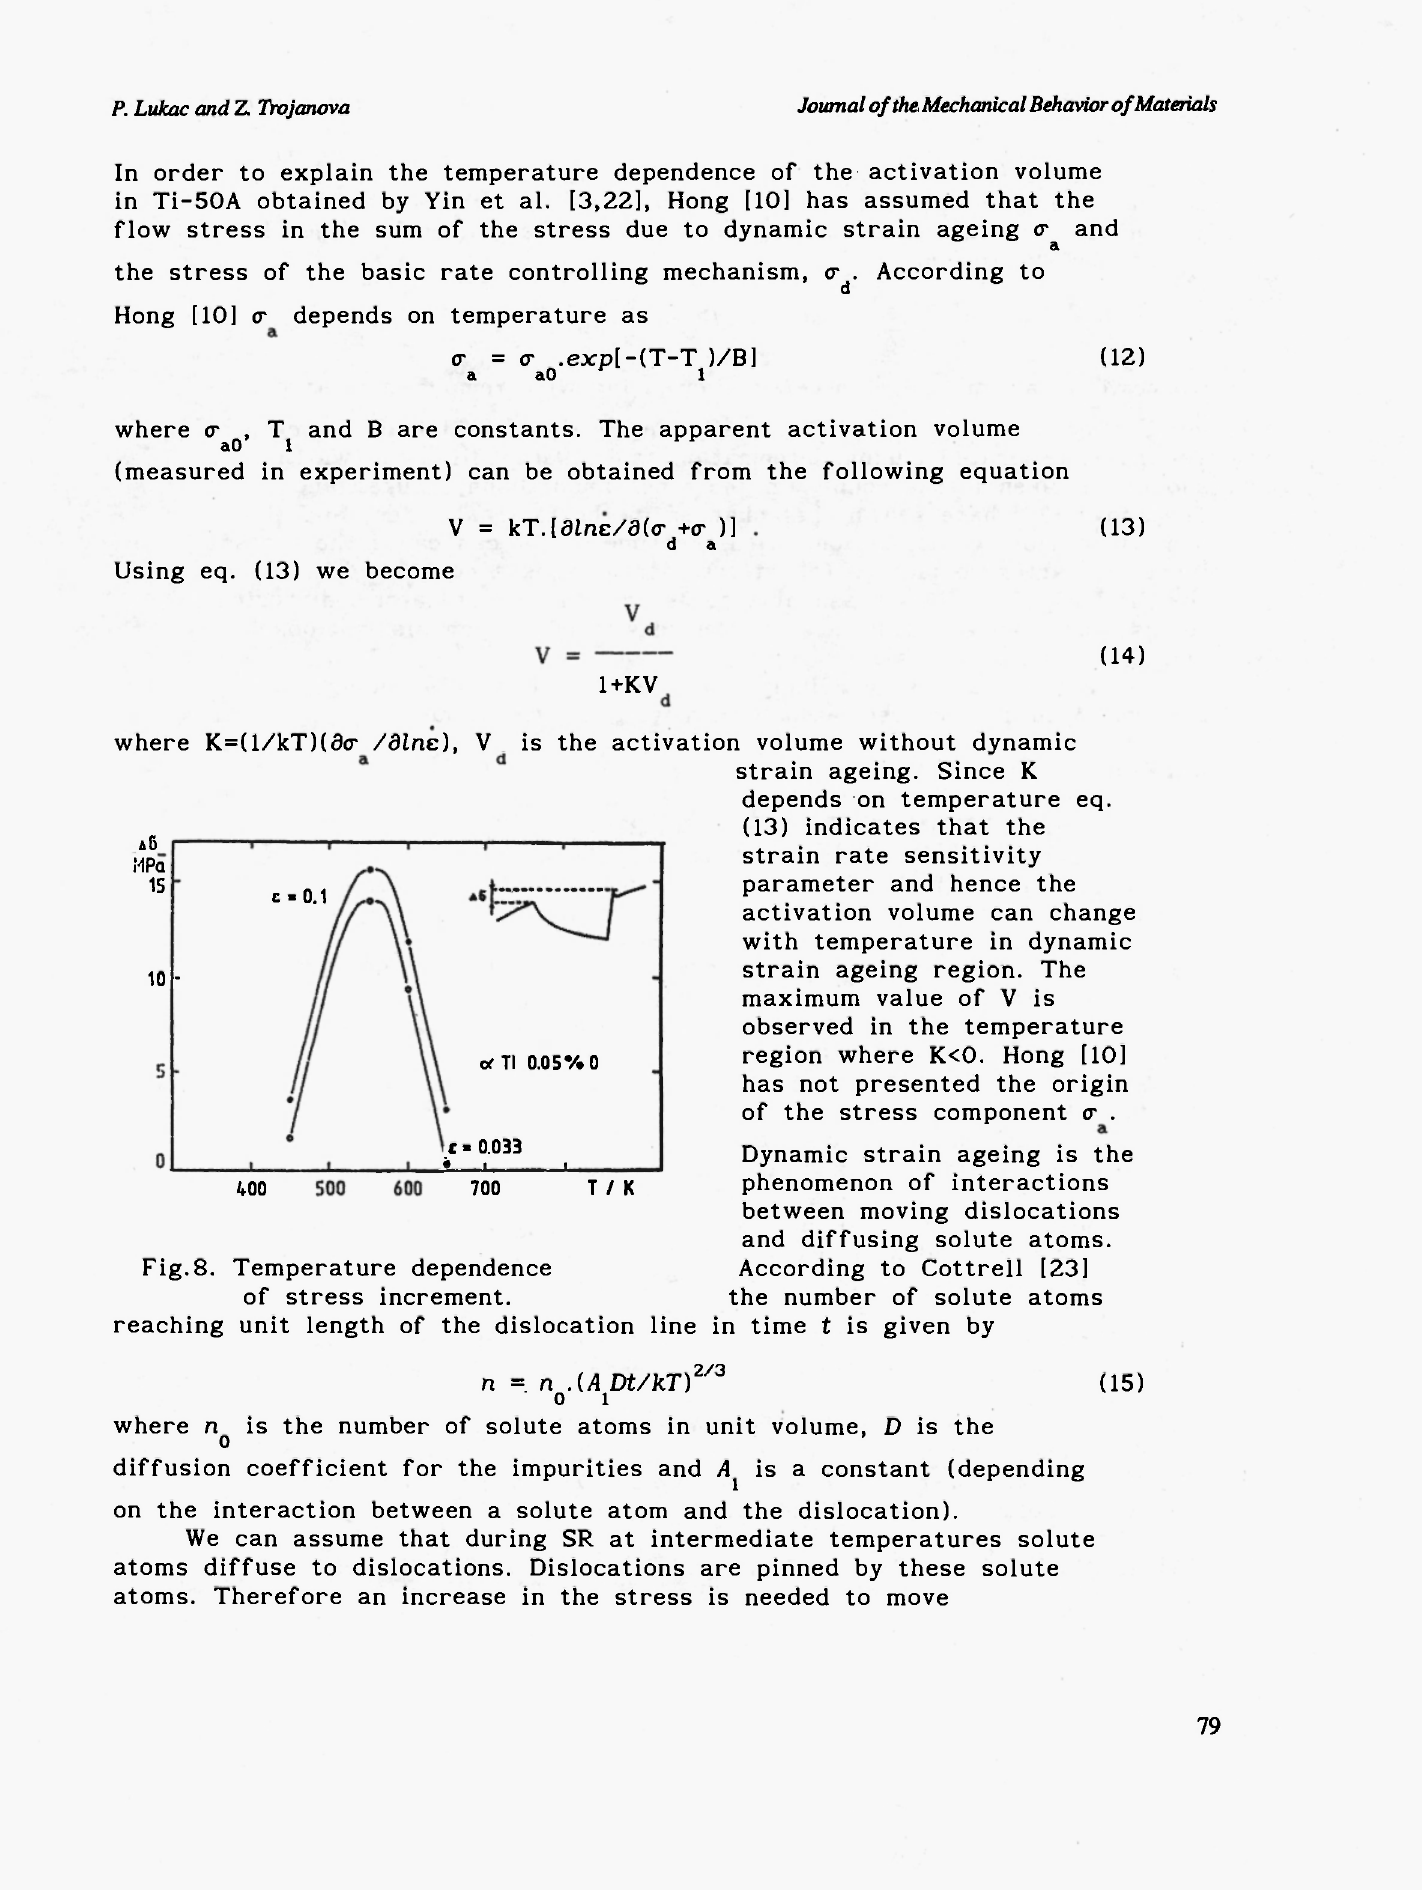
Dynamic strain ageing is the phenomenon of interactions between moving dislocations and diffusing solute atoms. According to Cottrell [23] the number of solute